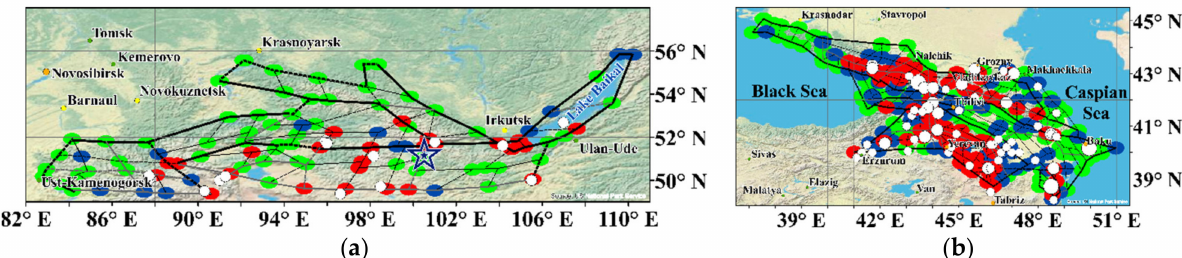
Figure 6. Presentation of a joint result of earthquake-prone areas recognition with M ≥ 6.0 by the Barrier-3 and Cora-3 algorithms as a fuzzy set of vicinities of the intersections of lineaments: ( a ) the Altai–Sayan–Baikal region (white circles— epicenters of earthquakes with M ≥ 6.0 (1900–2012); blue star—epicenter of the earthquake, which occurred on 11 January 2021); ( b ) the Caucasus (white circles—epicenters of earthquakes with M ≥ 6.0; minor ones—before 1900; medium ones— 1900–1992; major ones—after 1992). Highlighted in red are the vicinities of intersections of lineaments with membership function to the high seismicity set µ = 1; in blue, µ = 0.5; in green, µ = 0. The function µ is determined by the formula